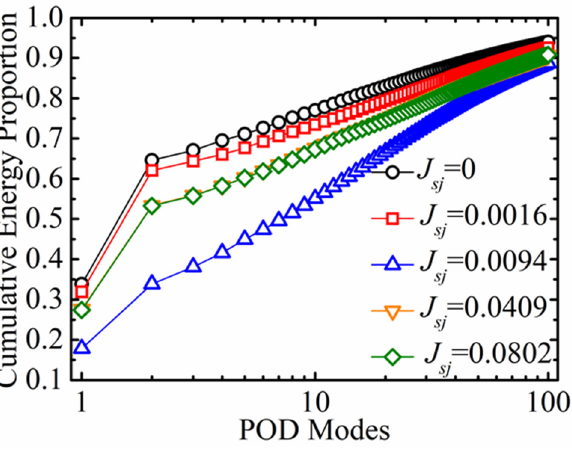
Figure 9. The cumulation energy proportion for the various POD modes.